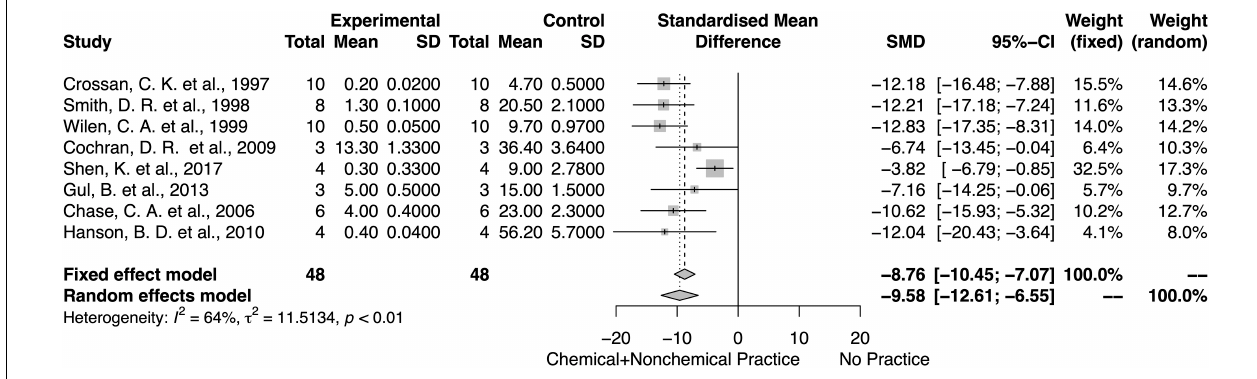
FIGURE 11 | Meta-analysis for the chemical and non-chemical combined weed control method on weed